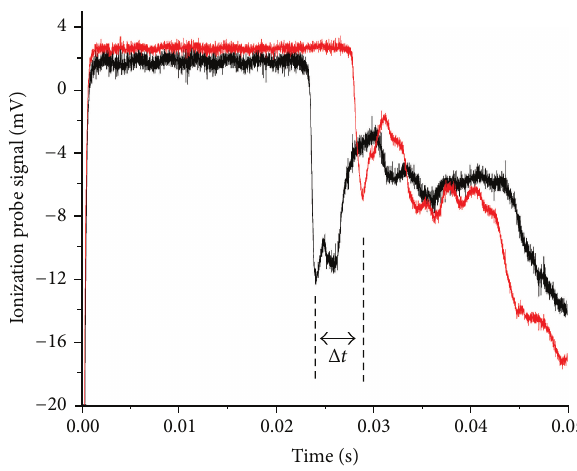
Figure 3: Representative voltage traces from the ionization probes from a sulfur